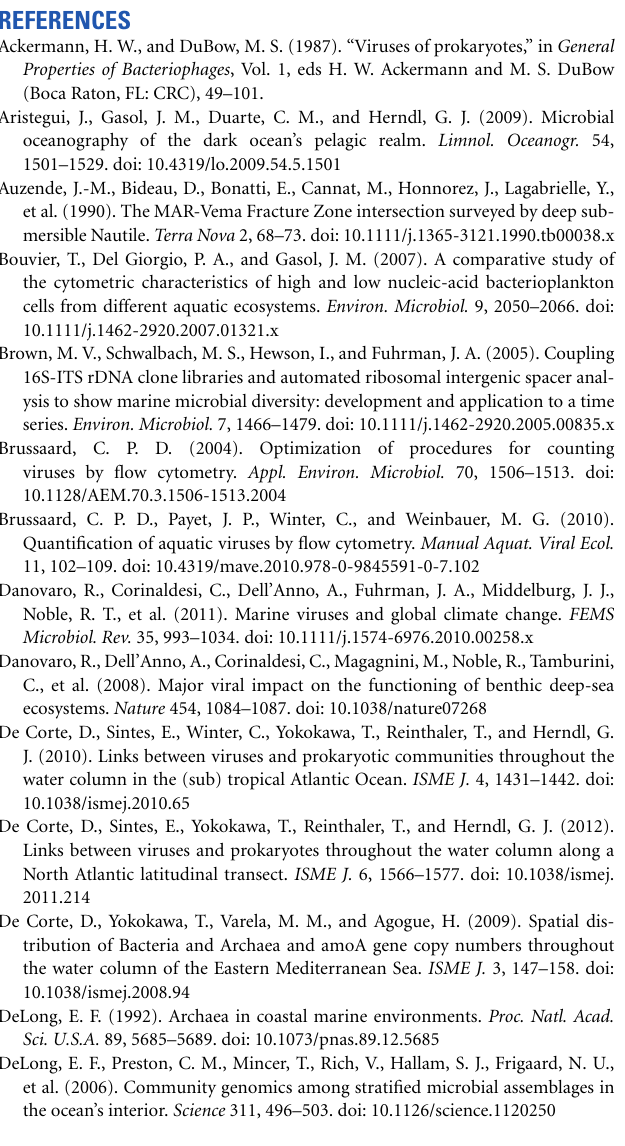
of high nucleic acid prokaryotes counted with high scatter; HNA-LS, percentage of high nucleic acid prokaryotes counted with low scatter; LNA, percentage of low nucleic acid prokaryotes; VirHigh, percentage of high fluorescent viruses; VirLow, percentage of low fluorescent viruses; VirMed, percentage of medium fluorescent viruses. Table S4 | Number of bacterial and archaeal operational taxonomic units (OTUs) revealed with reverse primers within the different water masses north, within and east of the Vema Fracture Zone in the (sub) tropical North Atlantic Ocean as revealed by T-RFLP. Abbreviations: Avg, average number of OTUs; SD, standard deviation; AABW, Antarctic Bottom Water; AAIW, Antarctic Intermediate Water; ArchRev, archael reverse primer; BacRev, bacterial reverse primer; N, number of samples; OMZ, oxygen minimum zone; LNADW, Lower North Atlantic Deep Water; Range, minimal and maximal number of OTUs; OTU, operational taxonomic unit; UNADW, Upper North Atlantic Deep Water. Numbers in bold are significantly different ( p ≤ 0 .